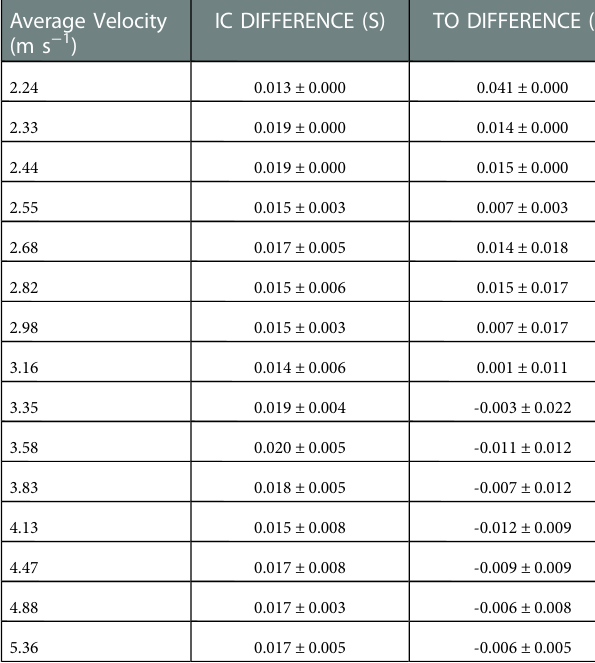
TABLE 4 LSTM estimated gait event